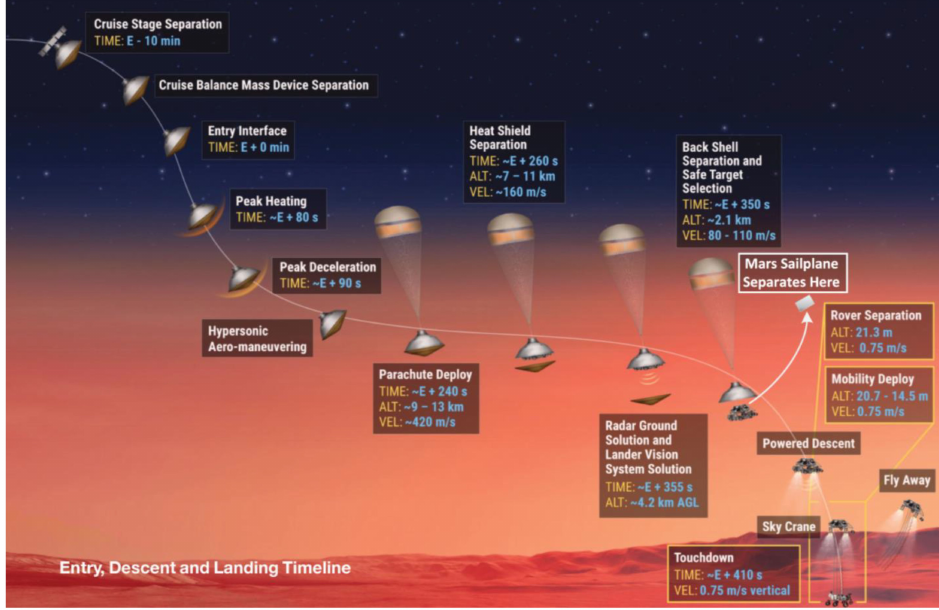
Figure 12. Entry, Descent and Landing Sequence for the Mars Science Laboratory/Mars 2020 Rover